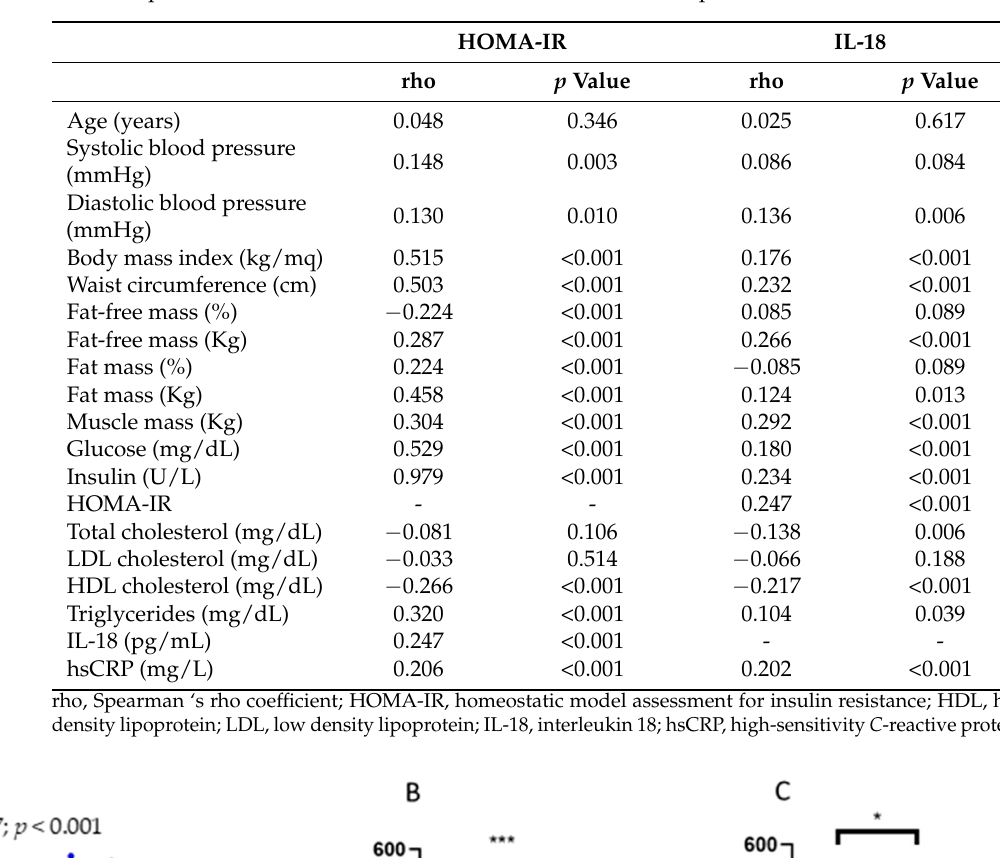
Table 2. Spearman correlation between Il-18 and HOMA-IR with parameters of interest.